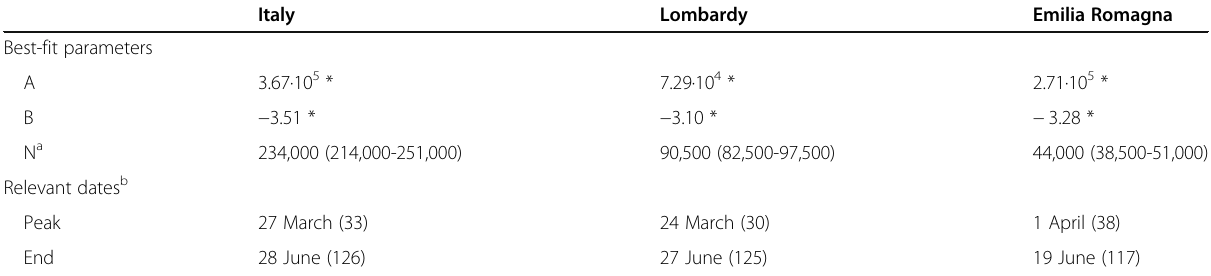
Table 2 Best-fit parameters and relevant dates obtained by the forecasted model for the epidemic caused by COVID-19 in Italy Italy